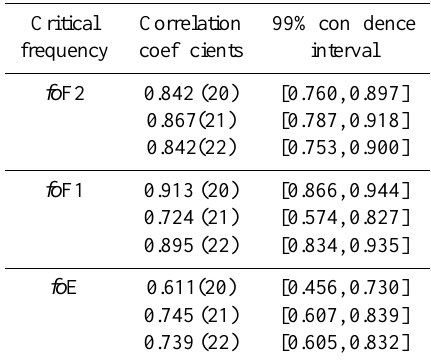
Table 5. Correlation coefficients and confidence